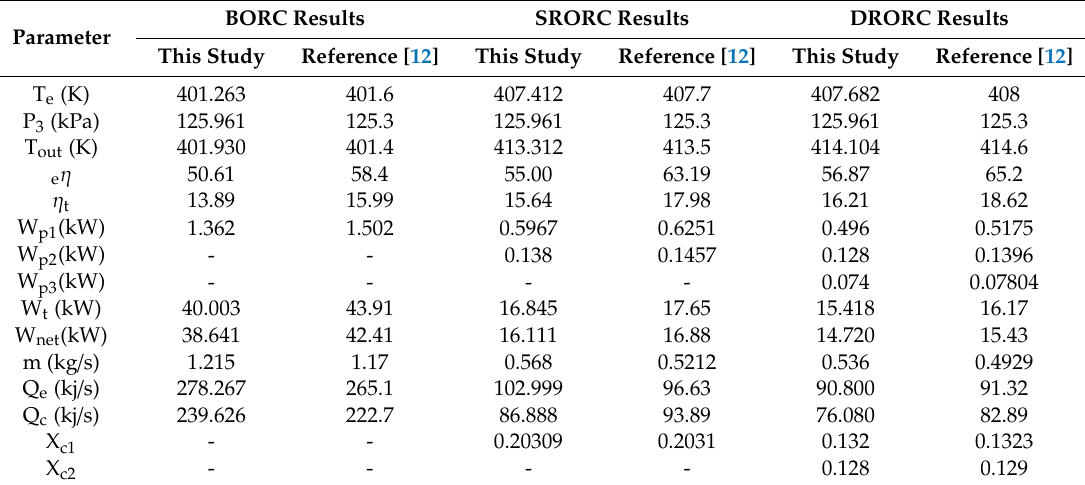
Table 4. Model validation of simulations by R11 with Reference